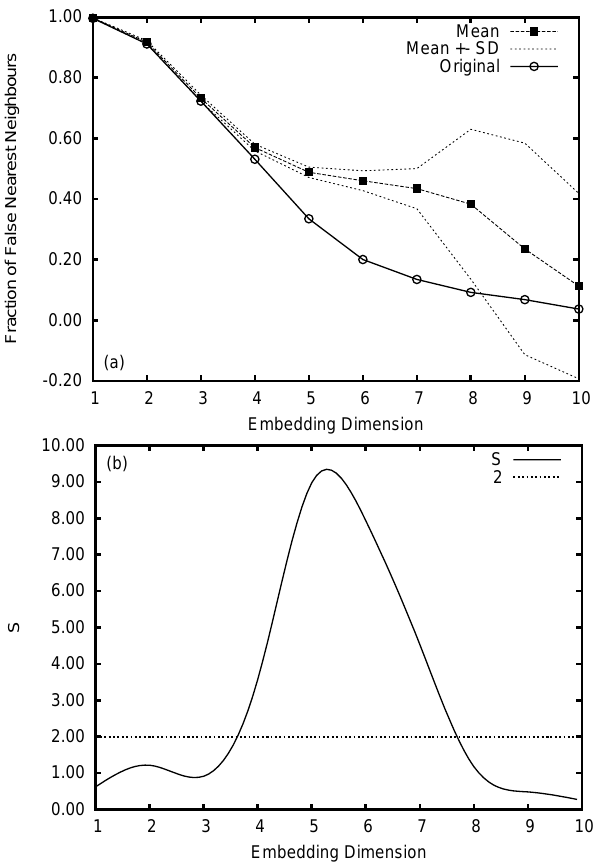
Fig. 12. (a) The mean values of the fraction of false nearest neigh- bours of the surrogates with standard deviation. (b) Plot of the sig- nificance of difference S versus m .